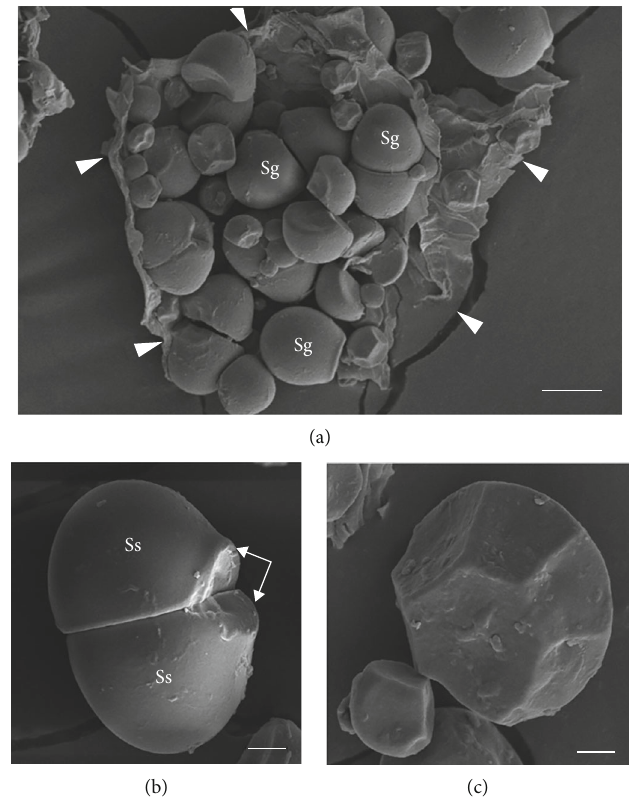
Figure 5: Scanning electron micrographs of starch granules observed in the fl our extracted from Sri Lankan cassava starchy roots. (a) Clusters of starch granules (Sg) enclosed in parenchyma tissues (demarcation indicated by white arrowheads) ( bar = 10 μ m ). (b) A starch granule with smooth surface (SS). Note the circular shape with fl at ends (white arrows) ( bar = 4 μ m ). (c) Starch granules with truncated shape. Note the size di ff erence of the two granules ( bar = 2 μ m